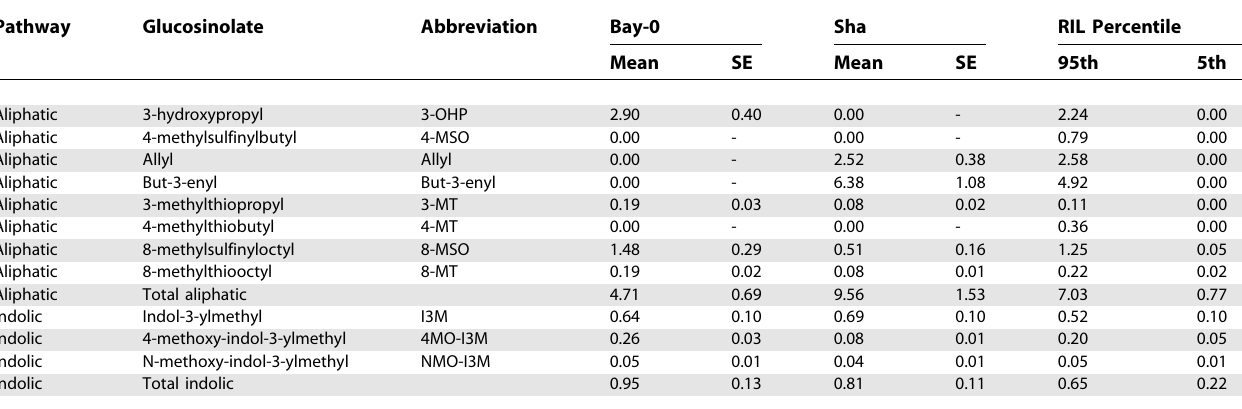
Table 1. Variation in Aliphatic Glucosinolates within Bay-0, Sha, and the Bay-0 3 Sha RILs Pathway